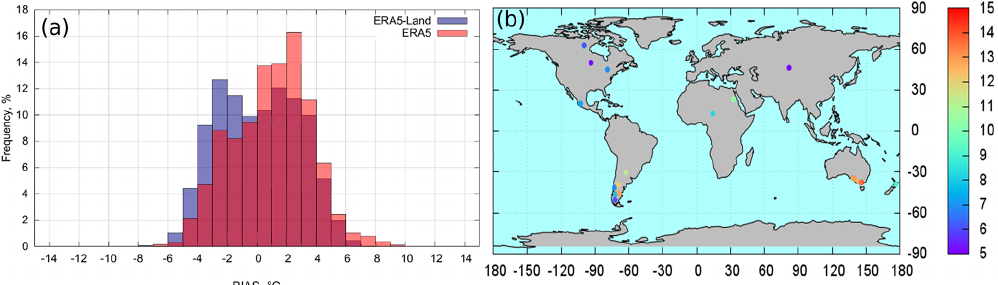
Figure 12. LSWT bias (observations minus ERA5 or ERA5-Land estimates) distribution ( ◦ C) for the 3-summer-month average data based on non-exceptional lakes (a) , and geographical distribution of the 26 exceptional lakes (glacier-fed, saline, and warm lakes) ERA5-Land MAE (b) with colour bar in ◦ C.